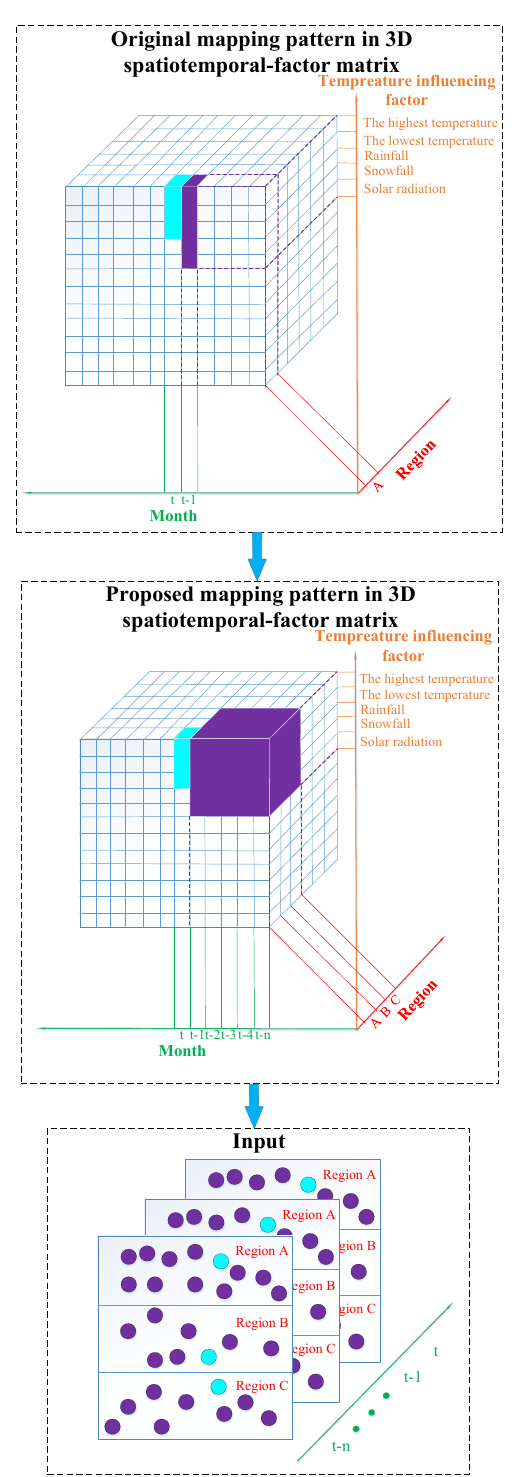
Figure 6. Improvement of input−output mapping pattern.